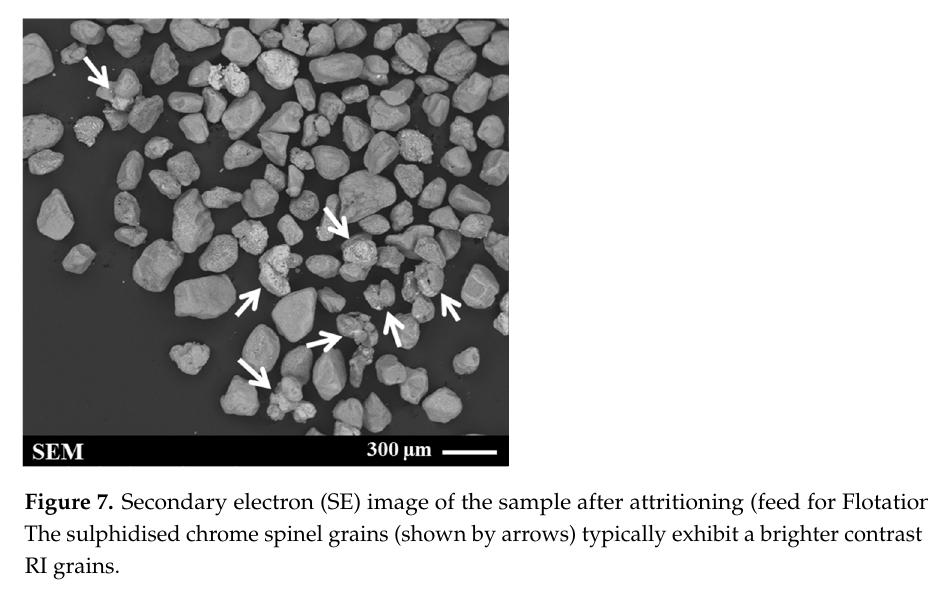
7 of 17 Figure 6. ( a ) A high-pressure filter used to de-water the tail sample; ( b ) after filtration tail sample (bottom right) and flotation concentrate (top right). 2.2.2. Attrition and Flotation A Denver flotation cell (Denver laboratory flotation machine, made in US, 3 L stain- less steel cell) modified to accommodate an attritioning head was used for the attritioning process. Approximately 311 g of RI sample (tail sample after Flotation Test‒1) was added